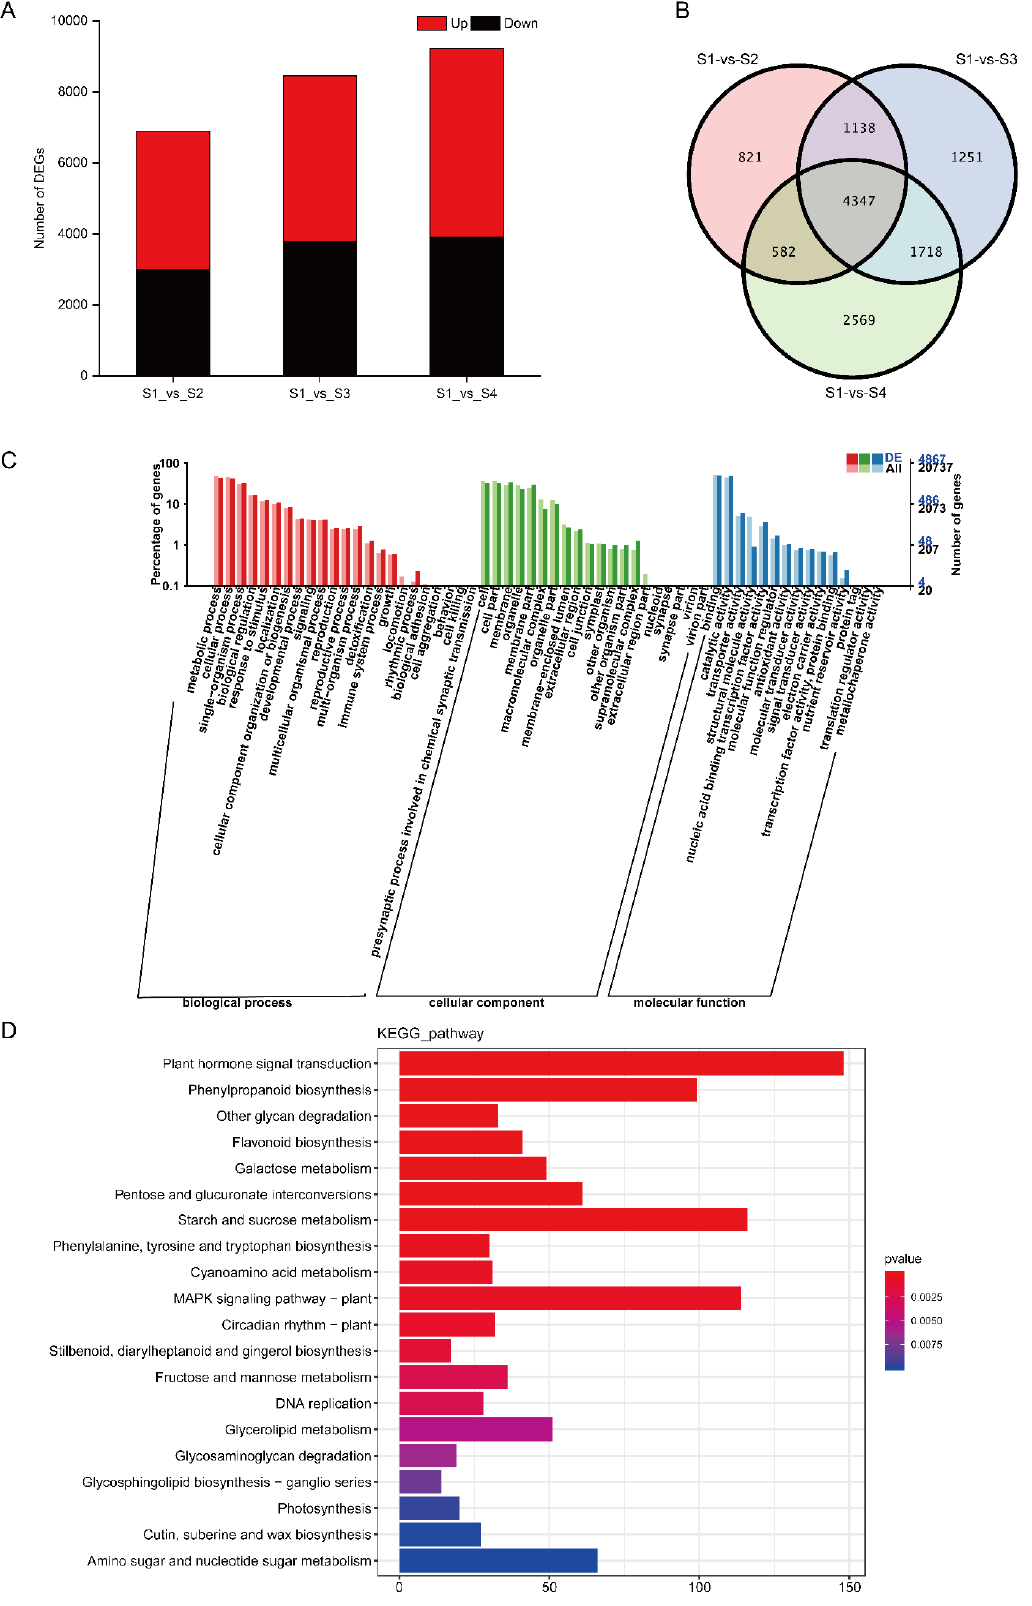
Figure 3. DEGs in four developmental stages of seeds. ( A ) Numbers of DEGs. ( B ) A Venn diagram of DEGs with S2/S1, S3/S1, and S4/S1. ( C ) GO classification of DEGs between S2 and S1. ( D ) KEGG pathways of DEGs between S2 and S1.